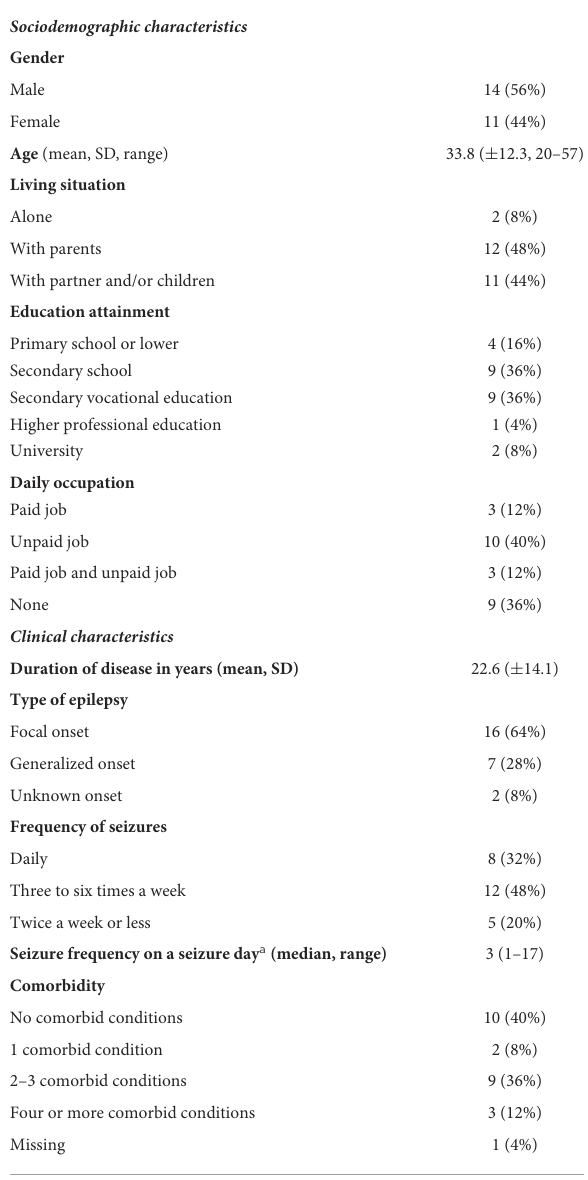
TABLE 1 Demographic characteristics at baseline (n =